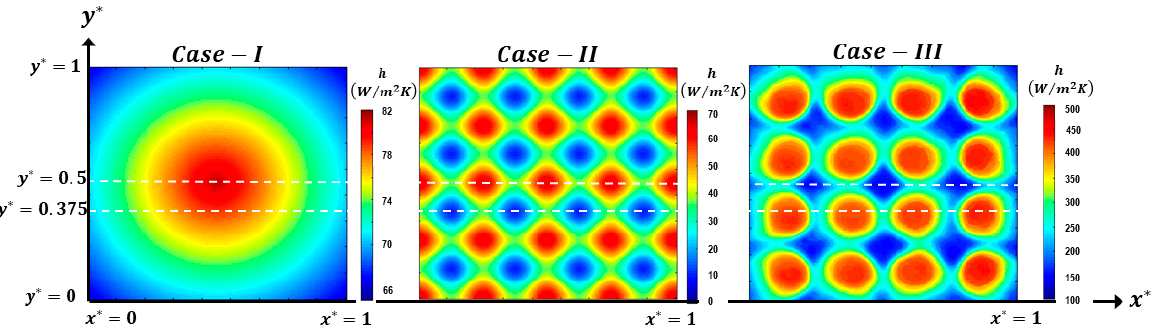
Figure 1. True h ( h 3 d ) distributions for Case I (single jet), Case II (array jet: theoretical distribution), Case III (array jet: experimental distribution). x ∗ = x / x max and y ∗ = y / y max